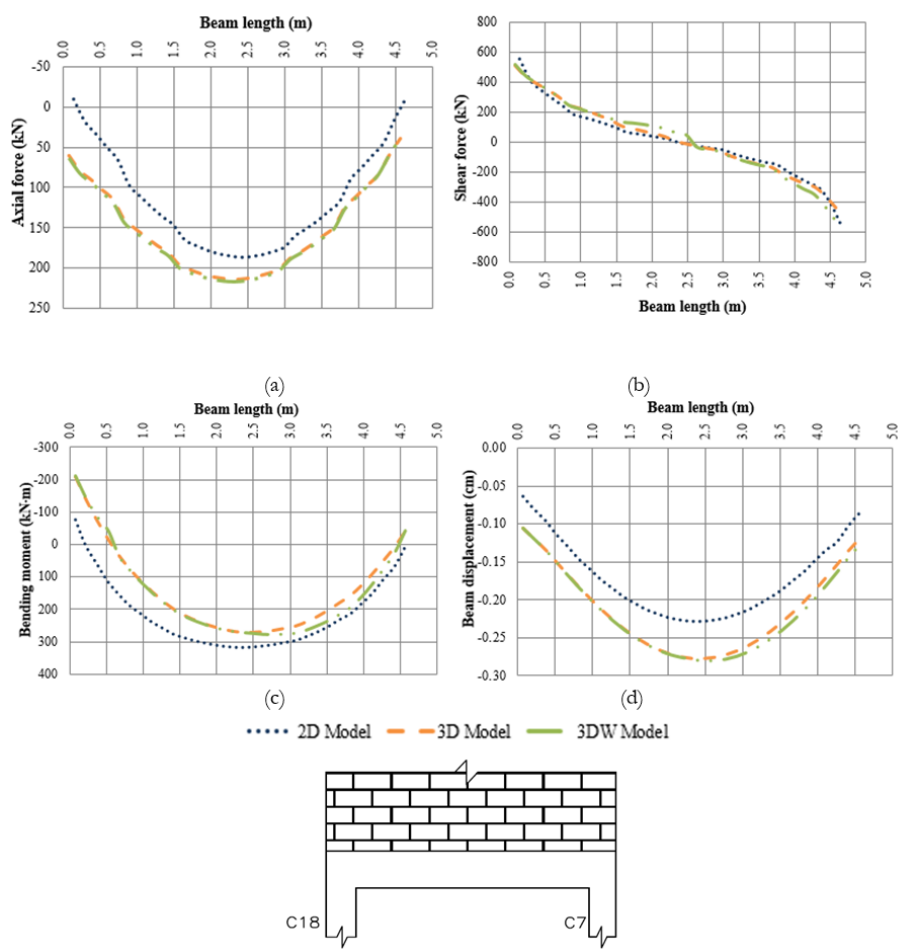
Figure 15. Forces on the support beam of wall 41: (a) Axial force; (b) Shear force; (c) Bending moment; (d) Vertical displacement.